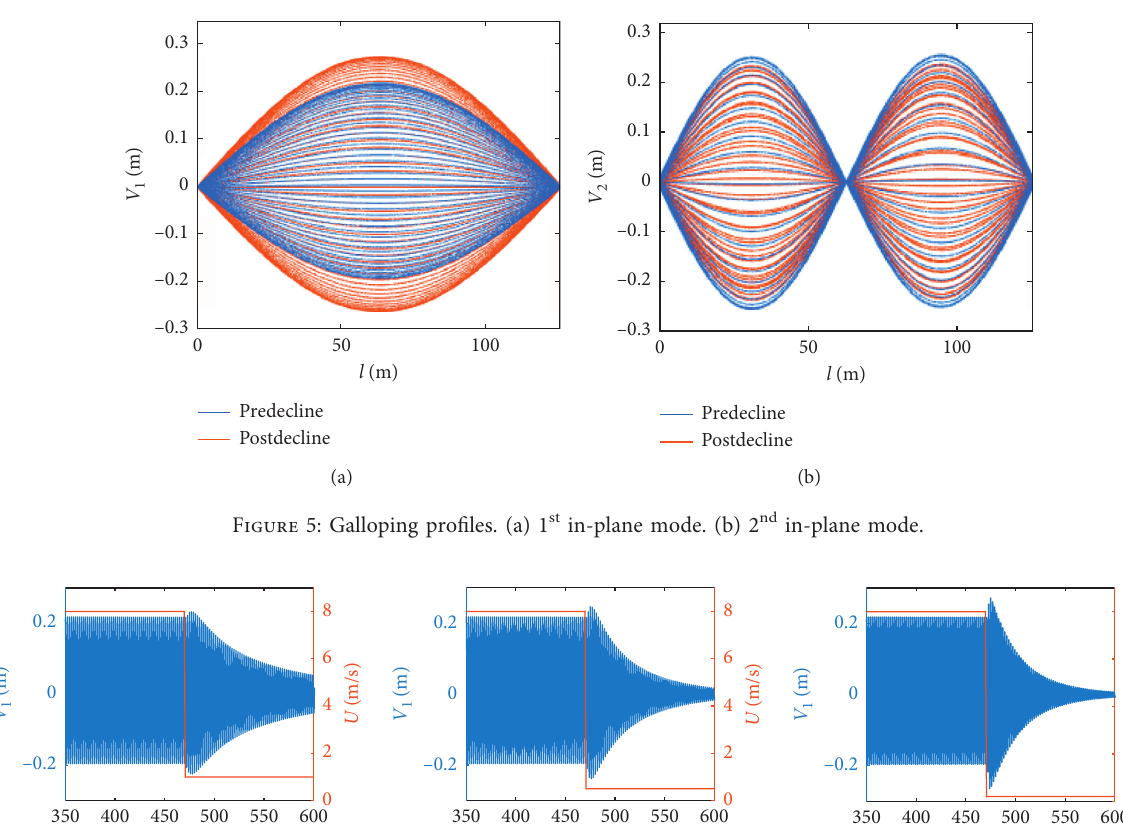
� 8m/s and t � 2s. (a) U � 1 m/s. (b) 1 d 2